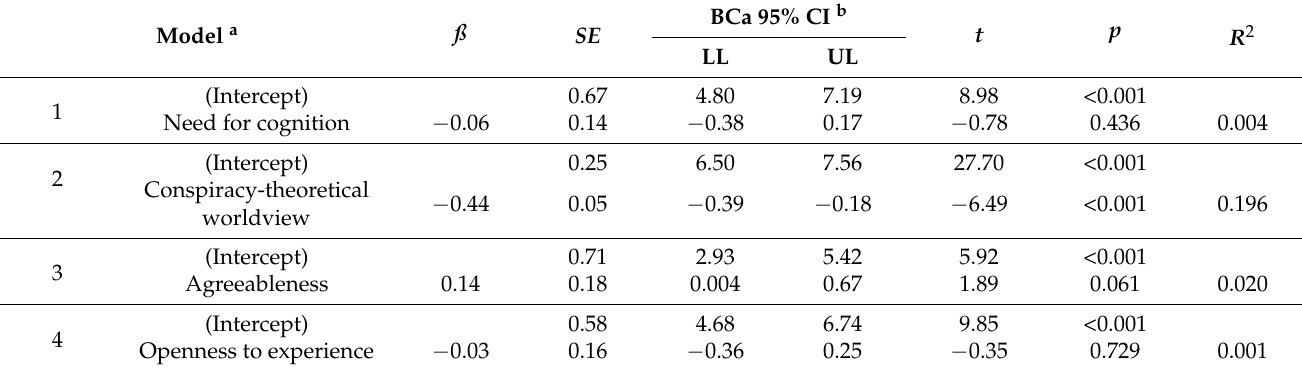
Table 2. Regression analysis: belief in scientific theories as criterion.